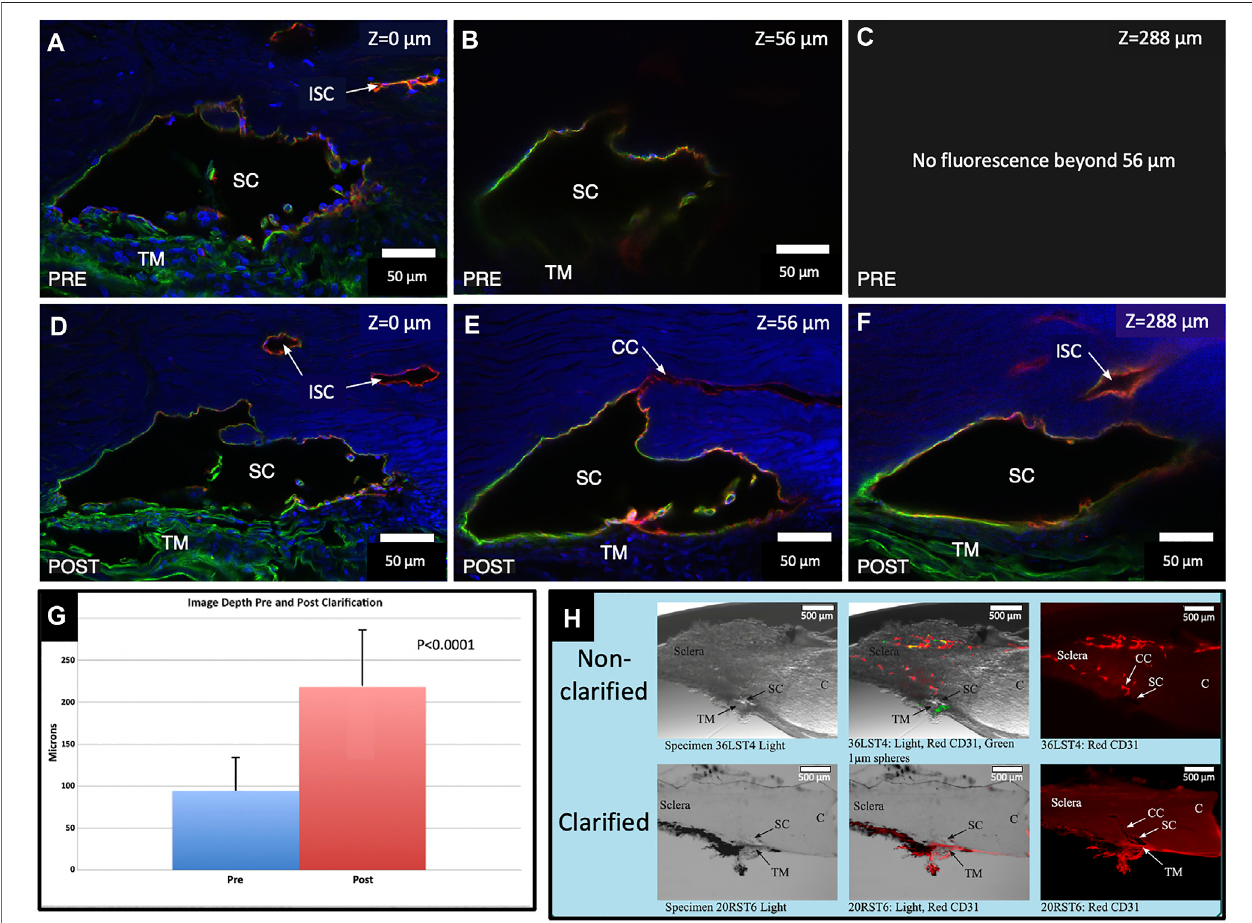
FIGURE 1 | Clari fi cation increases fl uorescence imaging depth. Comparison of pre- and post-clari fi cation of confocal microscopy z-stack image depth, following immunohistochemistrywithmergedchannelsofCD31(red),Coltype4(green),andDAPI(blue) (A,D) .ThesurfaceofthesegmentislabeledwithaZ-axisof0 µm.Subtle differences in composition noted in (A,D) are expected. We needed to position the segment in the well again after clari fi cation. (B) Preclari fi cation, the deepest practical imagingdepthwithanidenti fi ableoutlineofSCwasat56 μ m. (C) Fluorescence wasabsentbeyond56 µm. (D) Afterclari fi cation, the fl uorescent imagebrightness markedlyimproved. (E) AnotherimagecapturedatB ’ spreclari fi cation fl uorescencedepthlimitismuchbrighter.LightpassingalongthelumenofSCpermitsretentionof CD31 and the Col type 4 signals outlining the entire lumen of SC. (F) Deepest Z-axis fl uorescence viewing depth post clari fi cation was 288 µm into the stack. DAPI underwentmarkedsignalattenuationasdepthincreased,whereasboththeColtype4andCD31signalsappearundiminished.AColtype4signalispresentwithinSCin images (D,E) . (G) Chart demonstrating the maximum imaged depth captured pre- and post-clari fi cation. (H) Non-clari fi ed and clari fi ed segments compared with a light microscope channel (Left Panel), light and fl uorescence microscope channels (center panel), and CD31 channel only (right panel). After clari fi cation, the actual tissue becomes clear and transparent, which allows the fl uorescent IHC label to be identi fi ed more clearly and deeply into the segment stack #38LSN10.